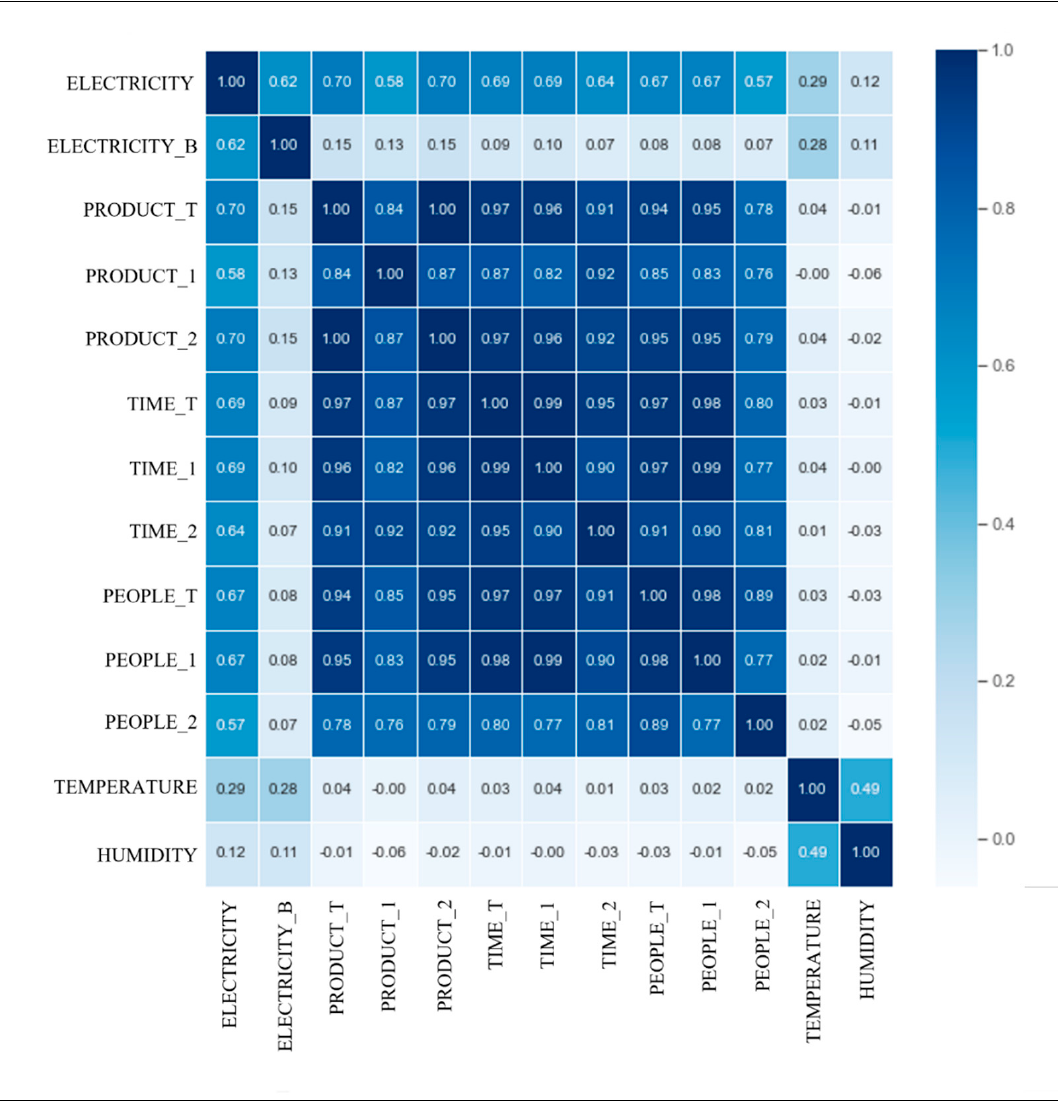
Figure 6. Correlations between the variables for the electricity consumption prediction.